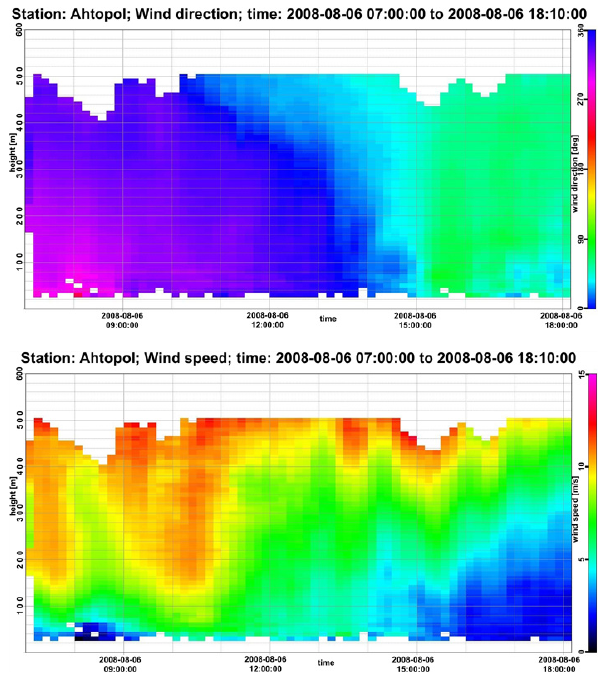
Figure 8. Notation is as in Fig. 6, but for 6 August